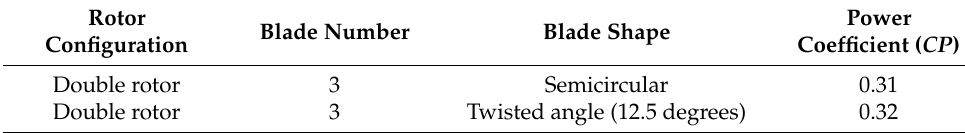
Table 4. Power coefficient results for the valve-added rotor [67–71].